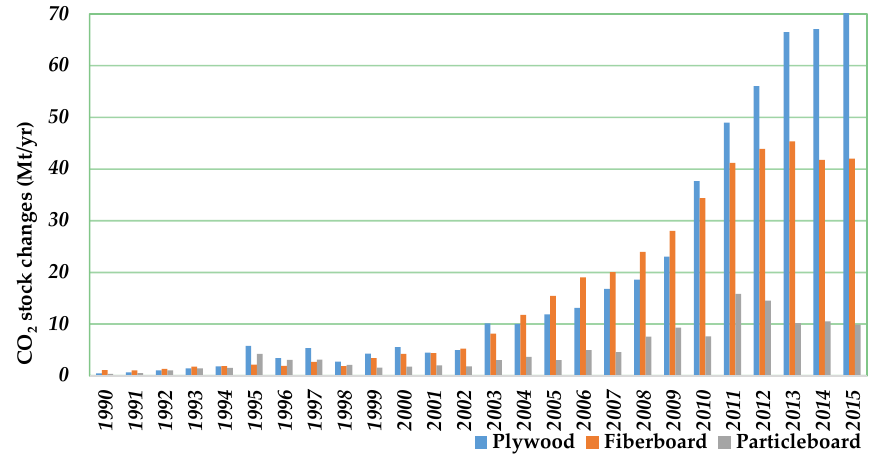
Figure 4. CO 2 stock changes of China’s wood ‐ based panels.